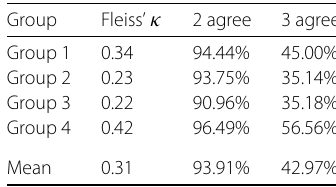
Table 2 Agreement computed according to Fleiss’ κ